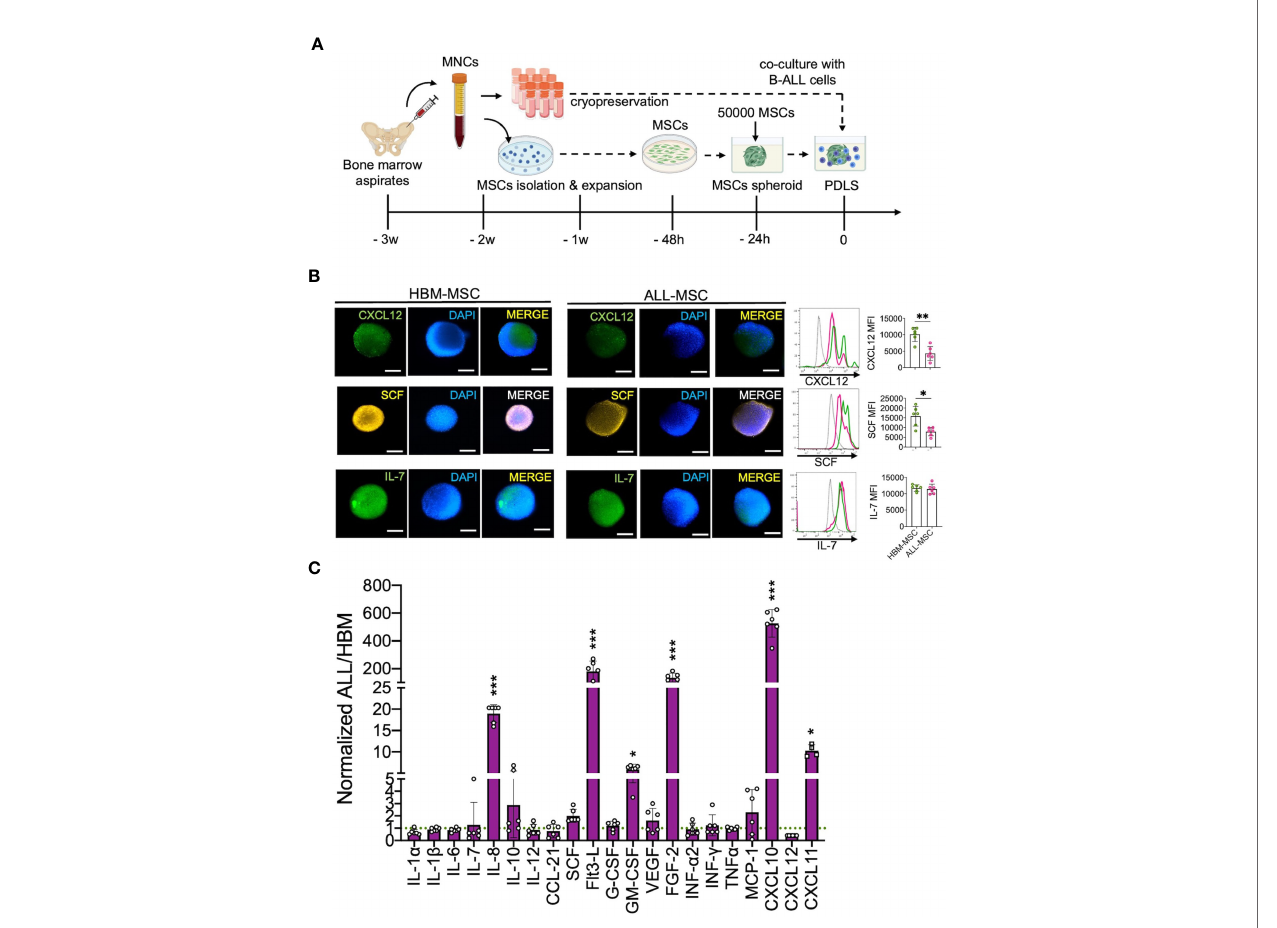
FIGURE 1 | B-ALL BM MSC form 3D spheroids endowed with high CXCL10 and CXCL11 production. (A) Mononuclear cells (MNCs) were obtained from healthy BM (HBM) donors or B-ALL patients, and MSCs were isolated by their adherent properties and were cryopreserved to be used in further experiments. (B) A total of 50,000 MSCs from HBM or B-ALL were induced to form a stromal multicellular spheroid, and CAR-cell derived factors (CXCL12, SCF, and IL7) were evaluated by immunostaining and FACS ( n = 6). (C) Growth factors, cytokines, and chemokine production from B-ALL-MSC spheroids (3D) were evaluated after collection of 24-h supernatants and normalized to HBM-MSC spheroids ( n = 6). MSC, mesenchymal stromal cell; HBM, healthy bone marrow; B-ALL, B-cell acute lymphoblastic leukemia; CAR-cell, CXCL12-abundant reticular cell; FACS, Fluorescence-activated cell sorting. *P < 0.05; **P < 0.01; ***P < 0.001. Error bars represent